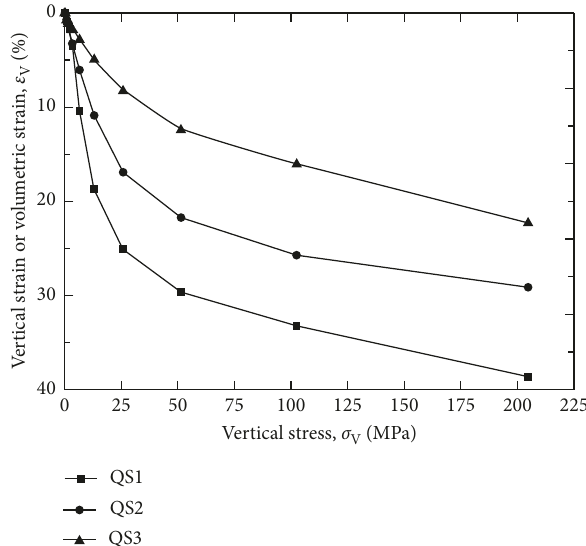
Figure 4: Relationship between ε